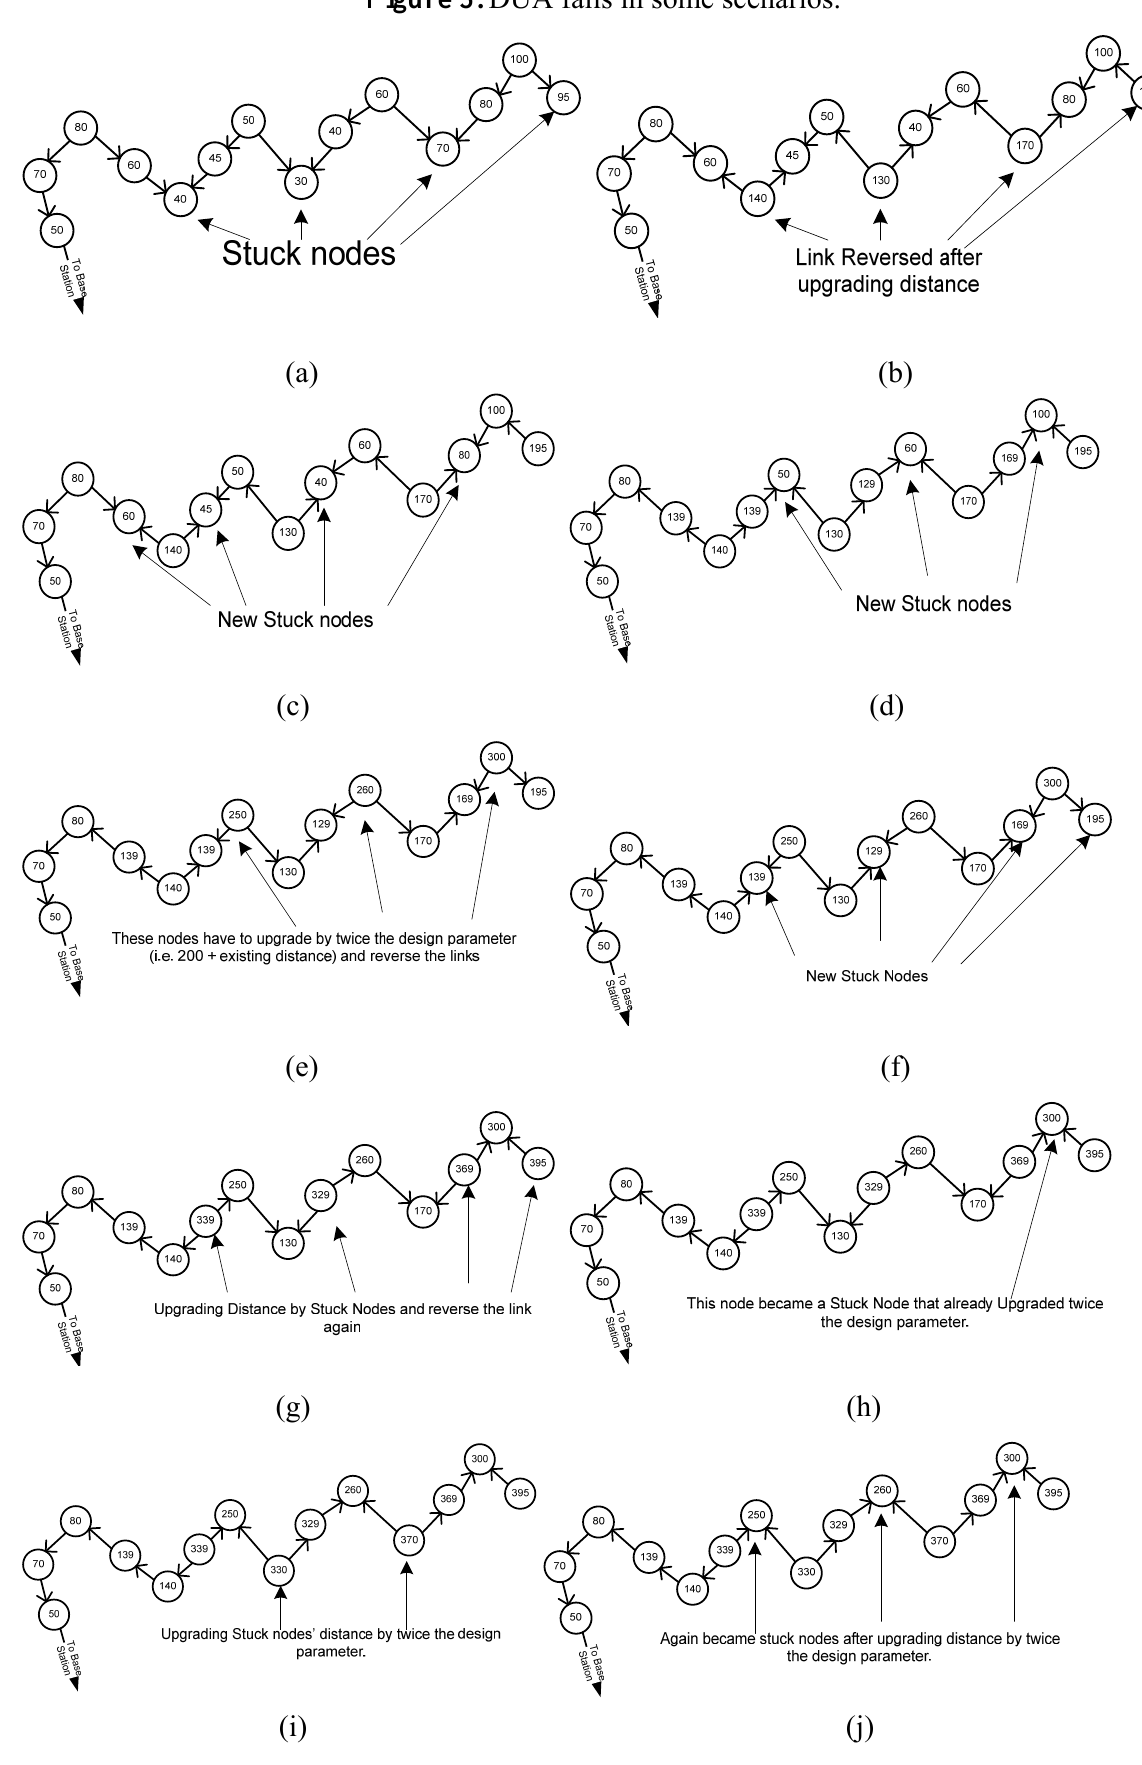
Figure 5. DUA fails in some